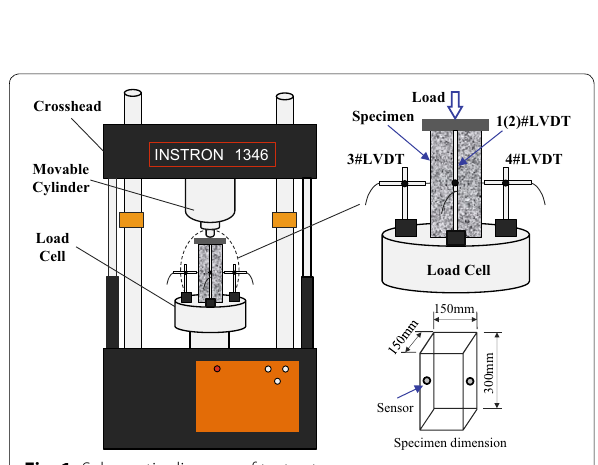
Fig. 1 Schematic diagram of test